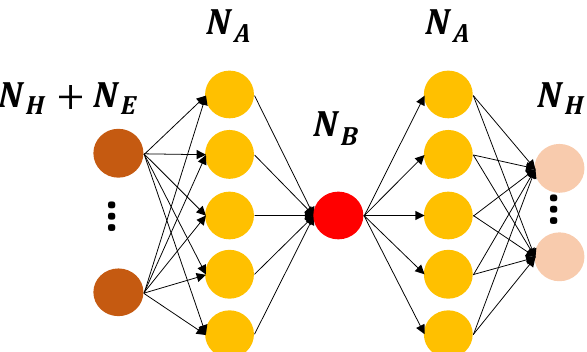
Figure 5. General scheme of the implemented ANN